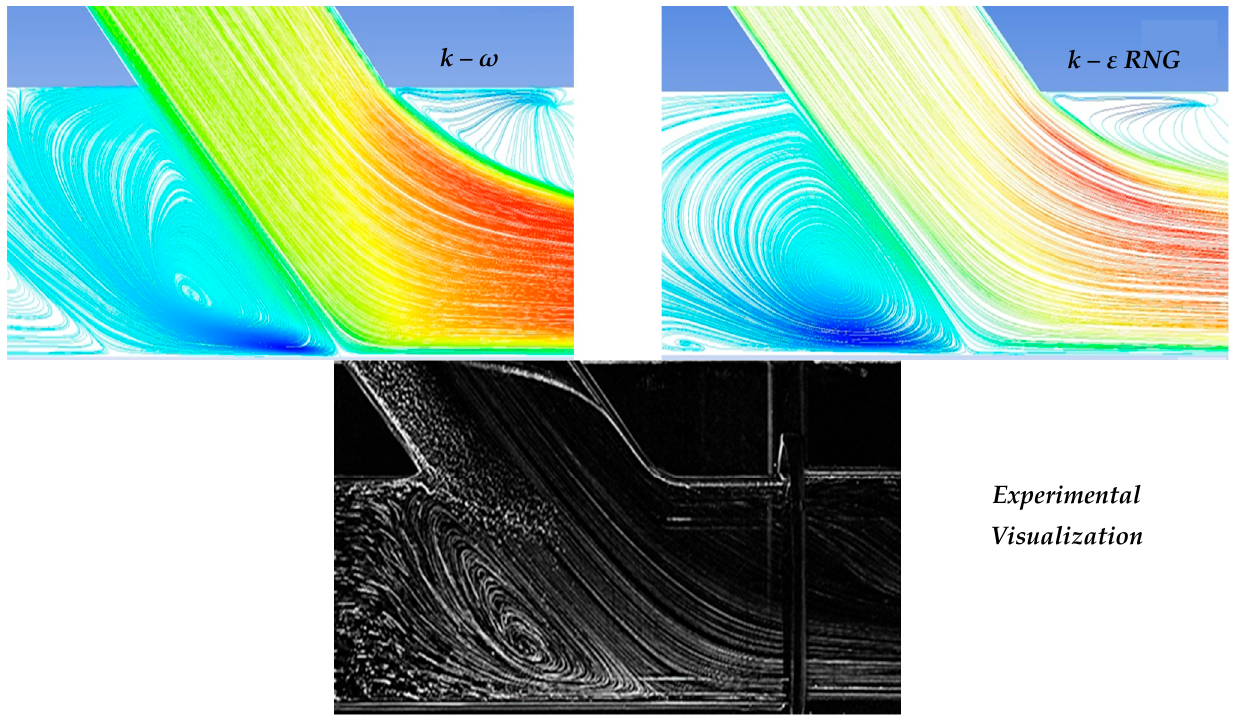
Figure 9. Qualitative comparison of flow models for 0–100% stenosis/anastomosis flow rate ratio.